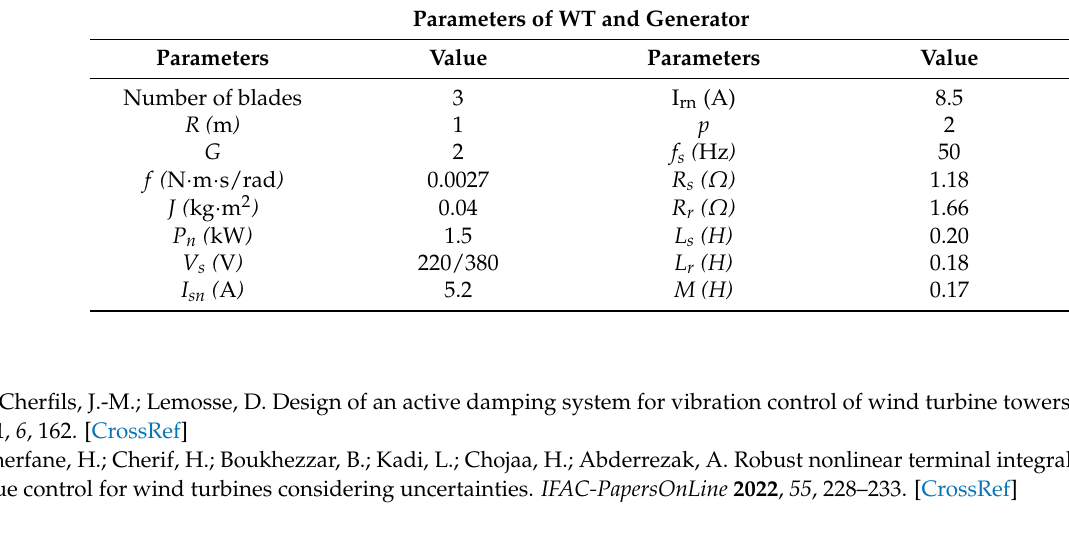
Table A1. Parameters of